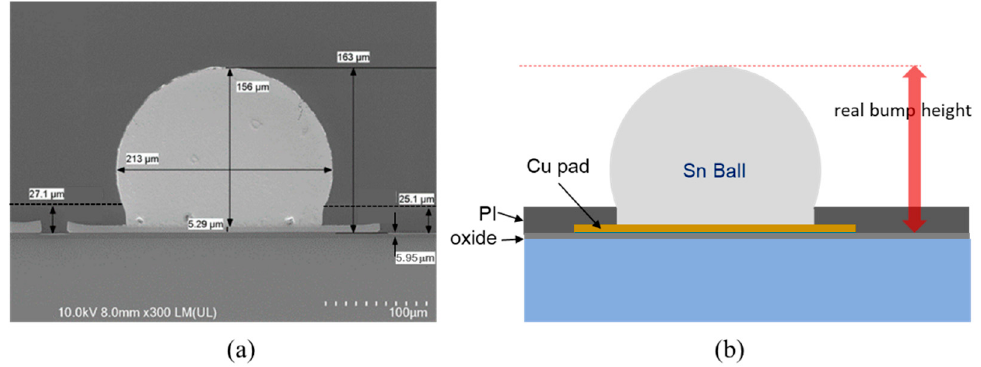
Figure 15. ( a ) Cross-section SEM results for a Sn bump on PL: bump height of 163 µ m, PL thickness of 25.1 µ m (right side)–27.1 µ m (left side), and oxide layer thickness of 5.95 µ m. ( b ) Schematic labeling the material in ( a ).